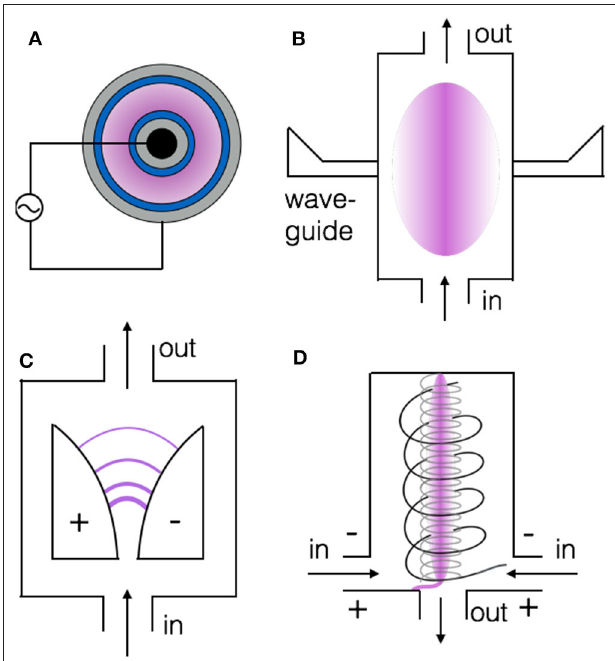
FIGURE 1 | Schematic picture of the three most common plasma reactors for CO 2 conversion, i.e., dielectric barrier discharge (DBD) (A) , microwave (MW) plasma (B) , and gliding arc (GA) discharge, in classical configuration (C) , and cylindrical geometry, called gliding arc plasmatron (GAP) (D) . The plasma is each time presented in purple. Adopted from Bogaerts and Neyts (2018) with